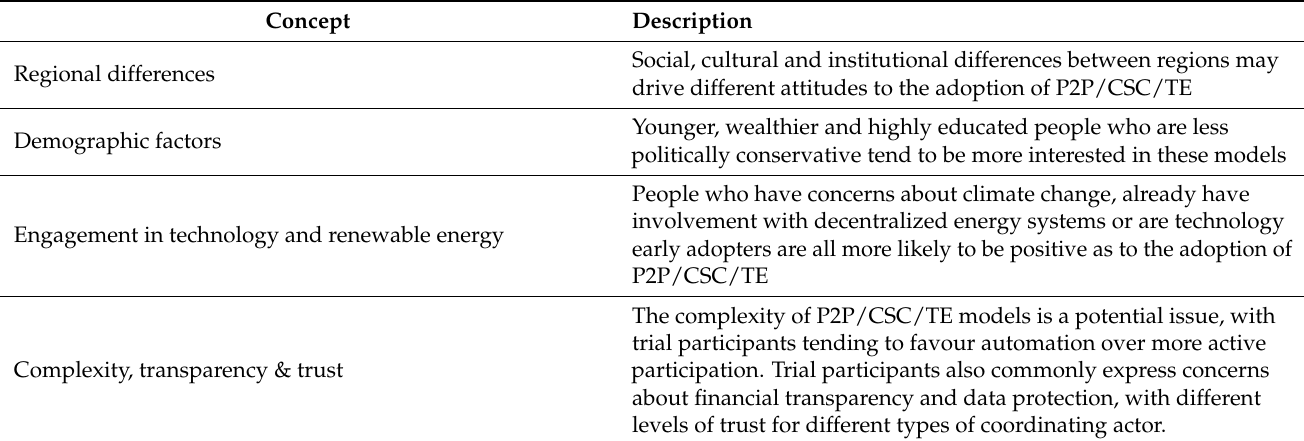
Table 5. Summary of the influence of participant characteristics and preferences on P2P, CSC and TE models.